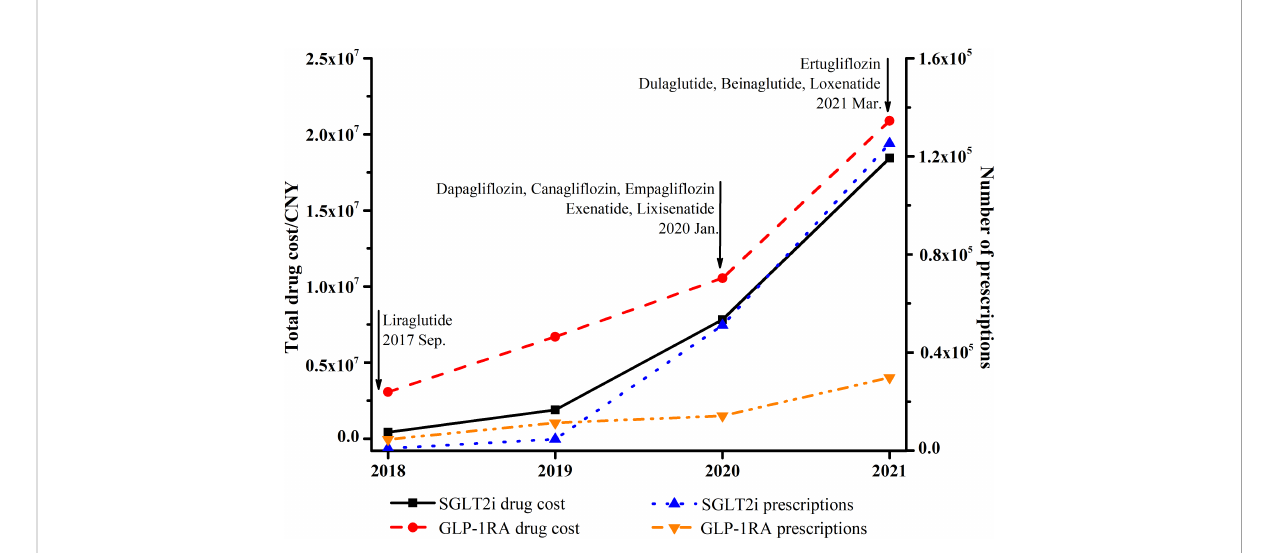
FIGURE 1 Total trends of expenditure and prescriptions of SGLT2i and GLP-1RA from 2018 to